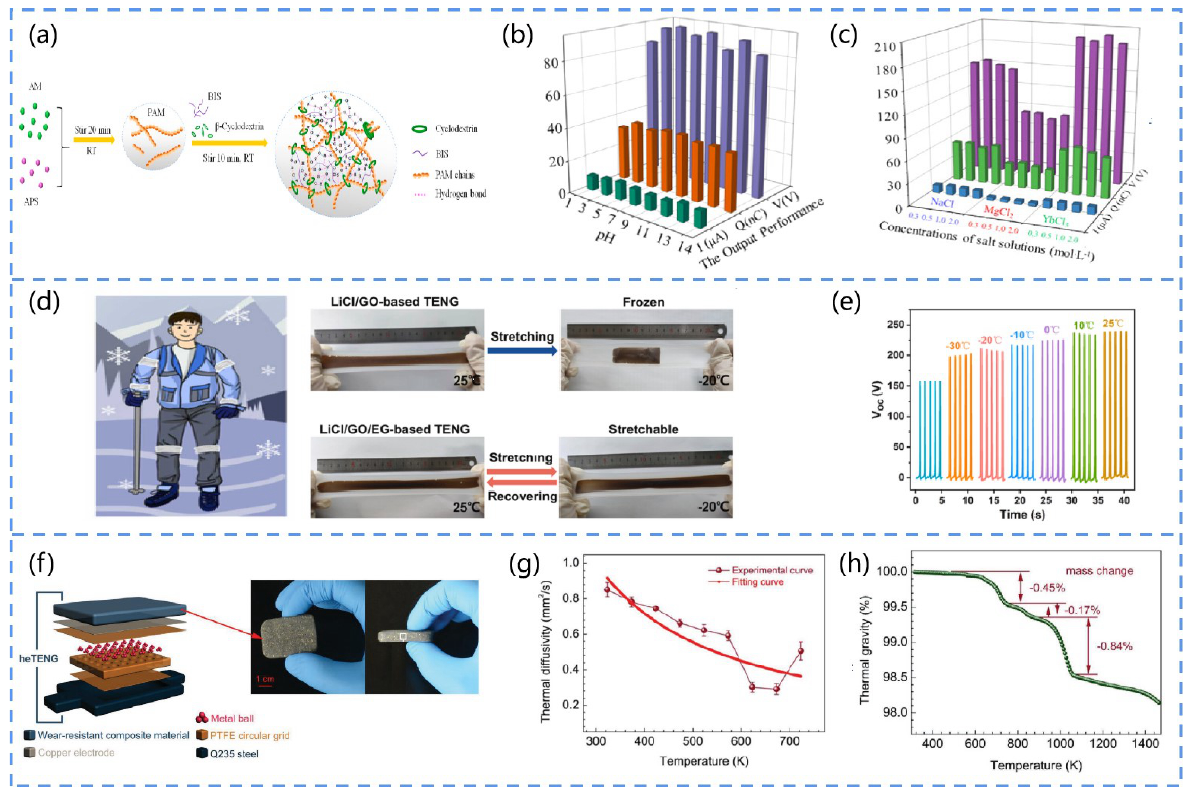
Figure 6. ( a ) Schematic diagram of the synthesis process of hydrogels. ( b ) Comparison of the output performance of the Cyc-TENG after treatment with aqueous solutions of different pH values. ( c ) Comparison of the Cyc-TENG output performance after treatment with different concentrations of salt solutions. Reprinted from [52] with permission from Elsevier. ( d ) Schematic diagram of the application of the AS-TENG in low-temperature environments and the stretchability of the TENG based on LiCl/GO electrodes and LiCl/GO/EG electrodes after cryogenic treatment. ( e ) Open-circuit voltage of the TENG at different temperatures. Reprinted from [53] with permission from Elsevier. ( f ) Diagram of the structure of the he-TENG. ( g ) Thermophysical properties of micro/nanocomposites. ( h ) Thermogravimetric measurements of micro/nanocomposites. Reprinted from [54] with permission from Wiley Online Library.